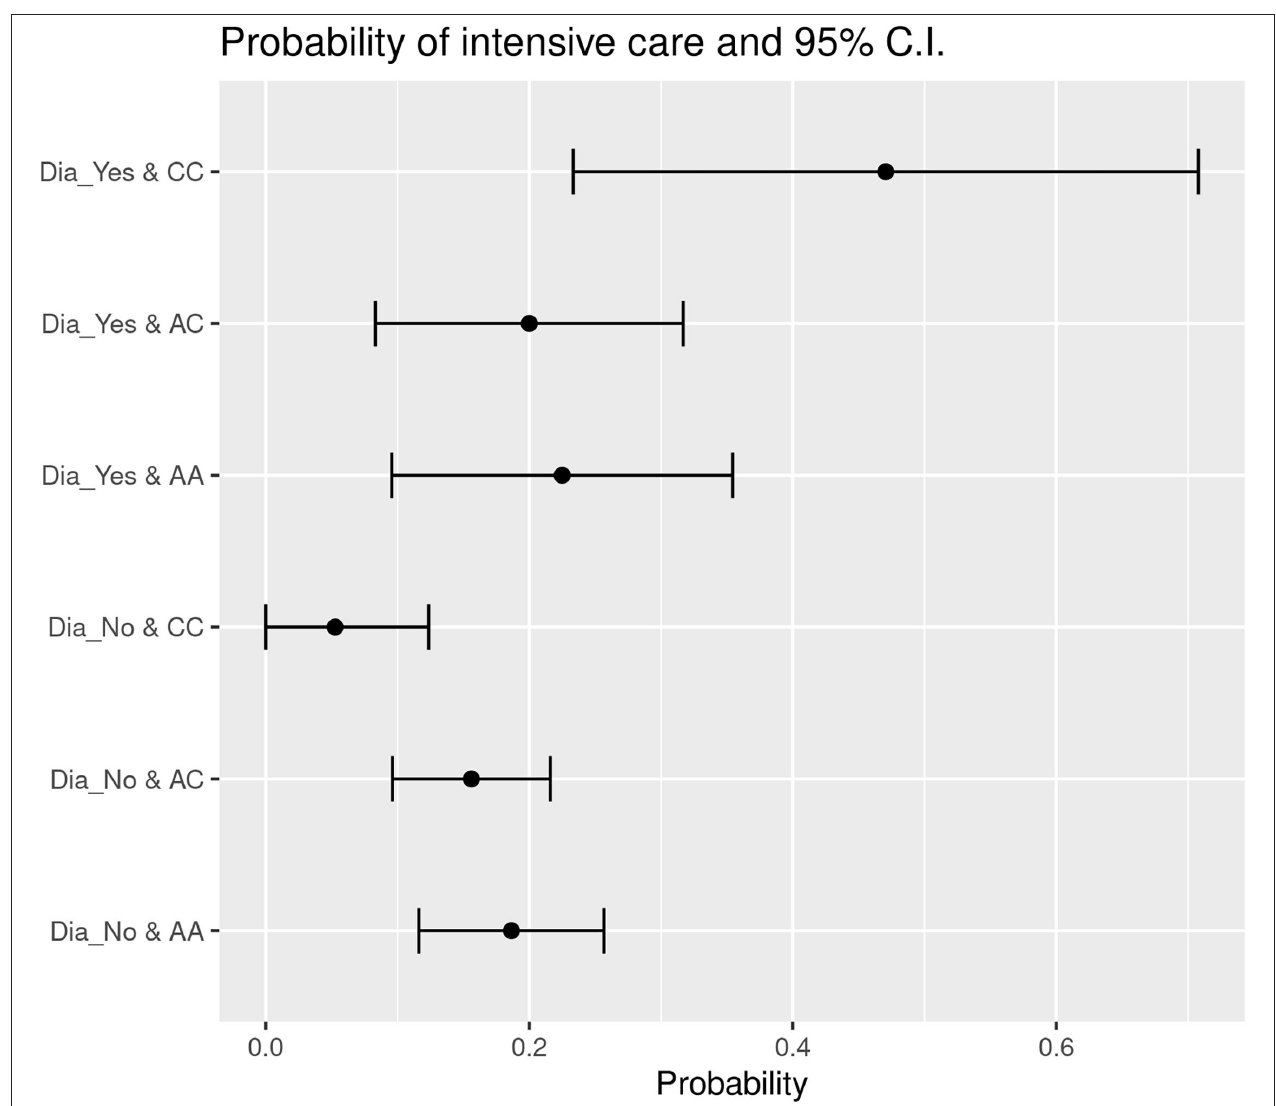
FIGURE 1 | Probability of ICU entrance subdivided based on the presence of diabetes in the different HSD3B1 polymorphism variants. In each specific polymorphic variant subgroup, the presence of diabetes increases the probability of ICU entrance. P1245C is the one with higher increment, showing an increase of 8.9 times in the presence of diabetes. AA, P1245A polymorphic variant; AC, P1245A > C polymorphic variant; CC, P1245C polymorphic variant; CI, confidence interval; Dia_Yes, the presence of diabetes; Dia_No, the absence of